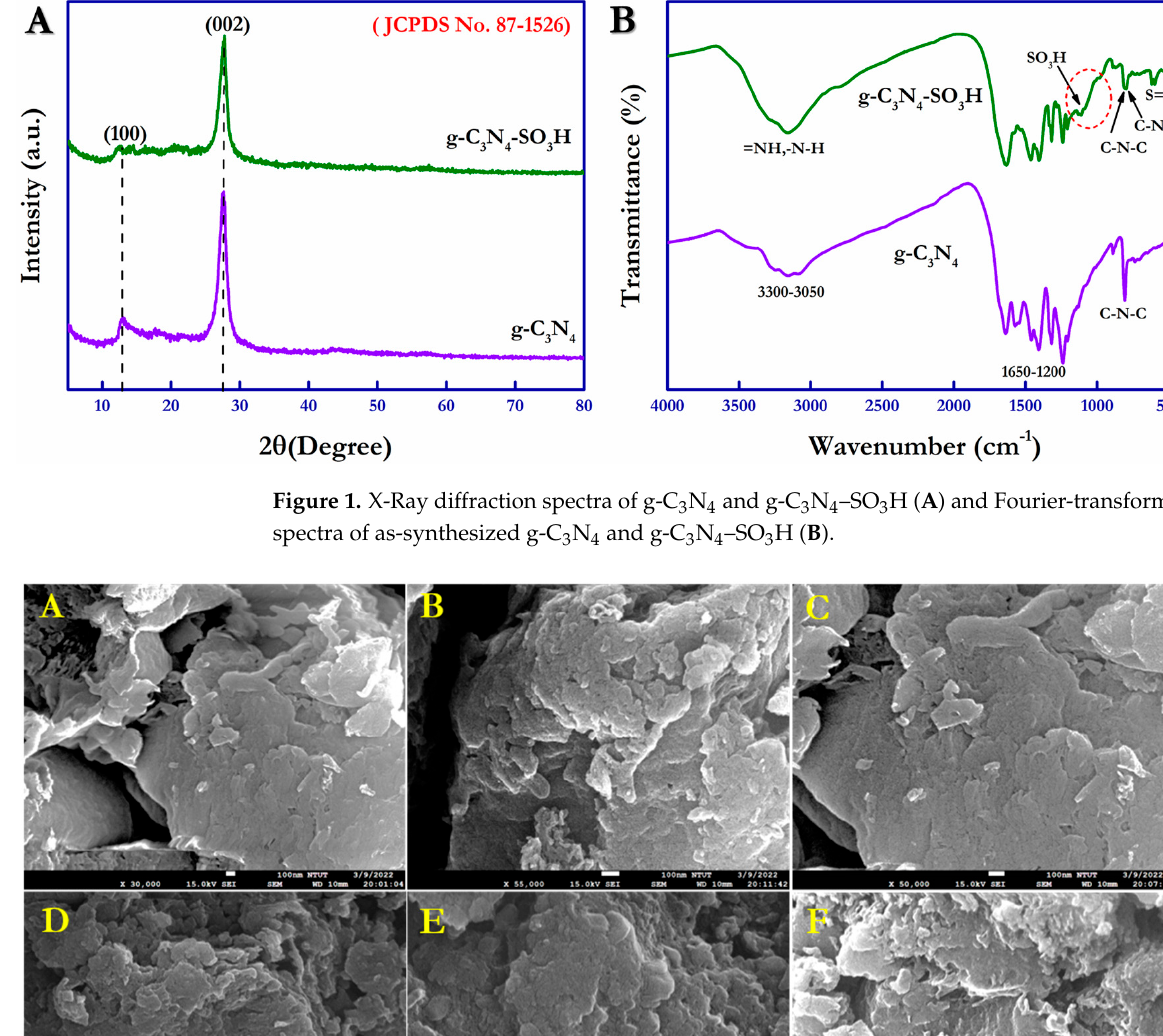
Figure 1. X-Ray diffraction spectra of g-C 3 N 4 and g-C 3 N 4 –SO 3 H ( A ) and Fourier-transform infrared